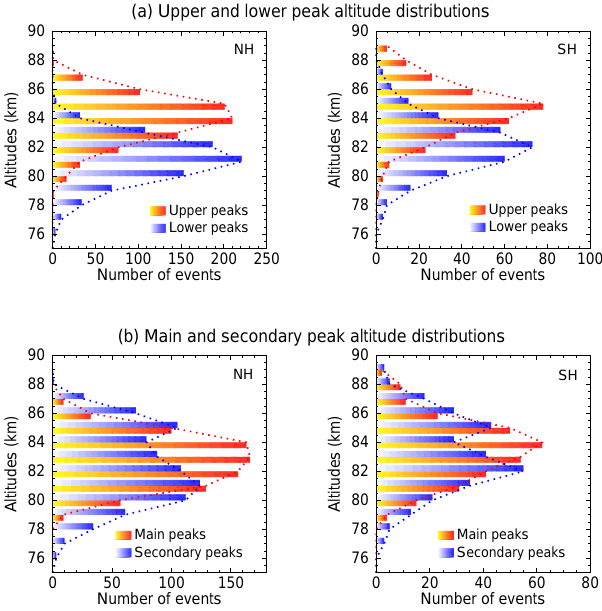
Figure 3. Histograms of peak altitudes with an interval of 1km. (a) Upper and lower peaks distributions for the NH and SH. (b) Main and secondary peaks distributions for the NH and SH. The dashed curves are the envelopes for the